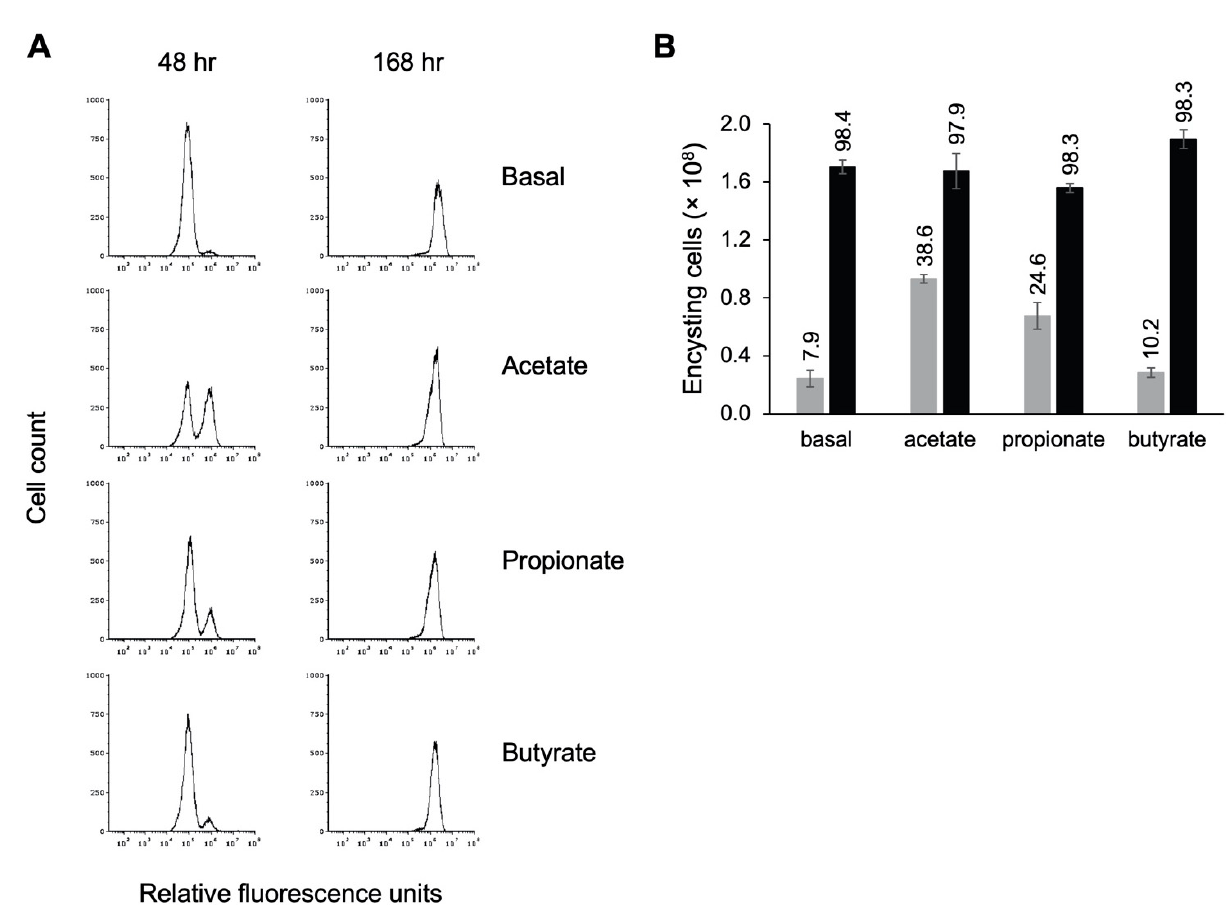
Figure 8. Short ‐ chain fatty acids speed entry into encystation. Replicate E. histolytica encystation cultures grown in TYI basal medium or TYI basal medium supplemented with 62 mM acetate, 24 mM propionate, or 23 mM butyrate were harvested at 48 and 168 h post ‐ inoculation, stained with WGA-488, and analyzed by flow cytometry. ( A ) Representative histograms display cell count versus relative fluorescence units and are uniform for comparison of the position and size of the peaks. Three biological replicates were performed, and the results shown are representative. ( B ) Total number of encysting cells and cysts at 48 h (gray bars) and 168 h (black bars) post-inoculation. Values are the mean ± standard deviation for three biological replicates. The percentage of live encysting cells is indicated above each bar.